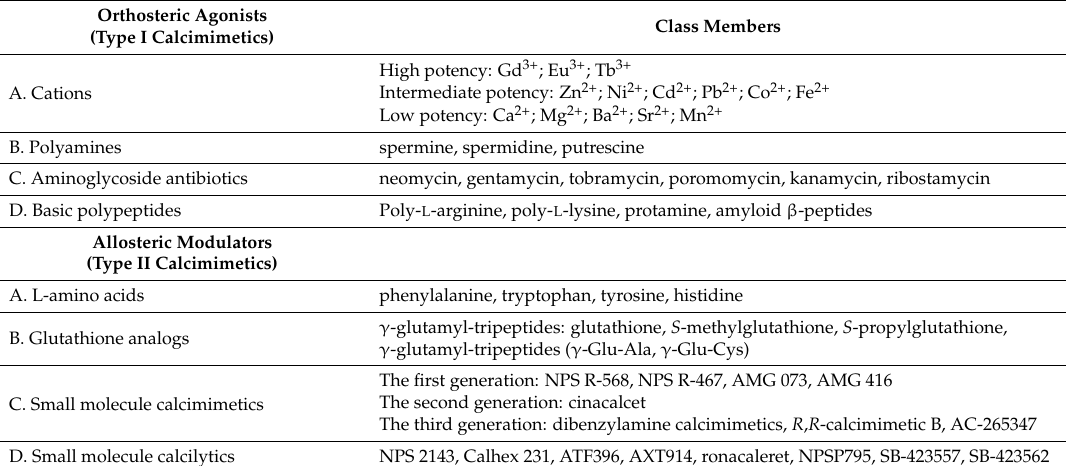
Table 1. Orthosteric agonists and allosteric modulators of the calcium-sensing receptor (modified from